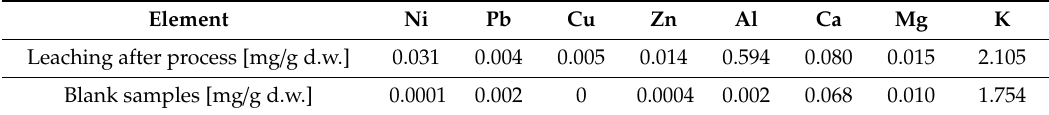
Table 1. Leaching elements from sediments during the modified Fenton process (pH = 3, t = 1 h). Element Ni Pb Cu Zn Al Ca Mg K Leaching after process [mg / g d.w.] 0.031 0.004 0.005 0.014 0.594 0.080 0.015 2.105 Blank samples [mg / g d.w.] 0.0001 0.002 0 0.0004 0.002 0.068 0.010